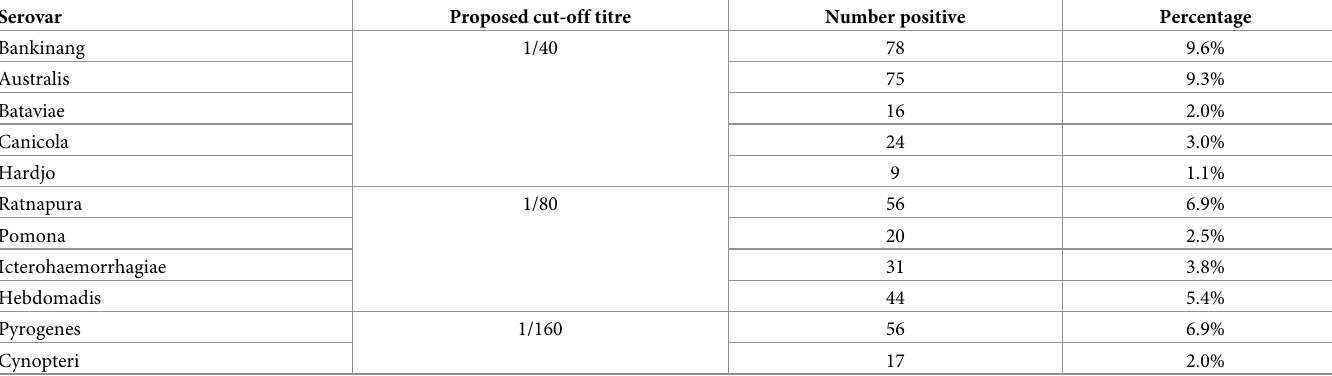
Table 4. Adjusted seroprevalence for pathogenic serovars based on proposed cut-off titers. Serovar